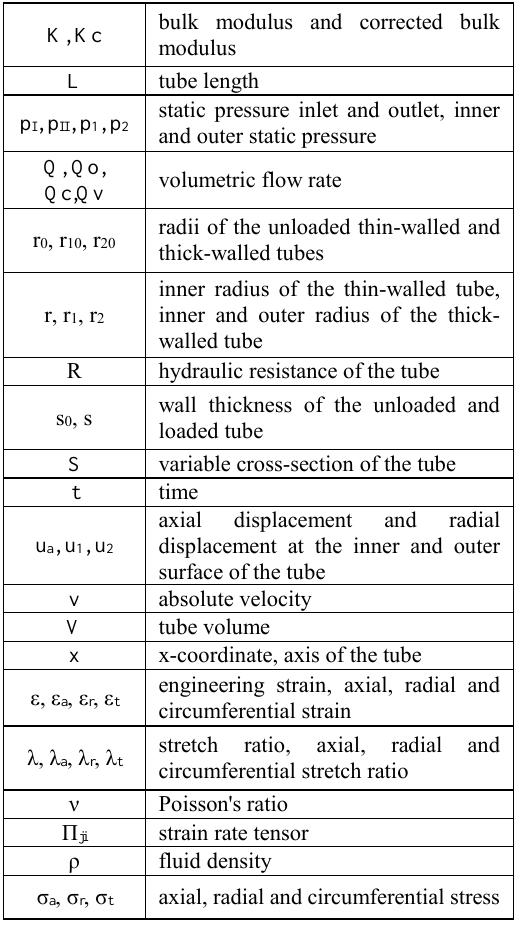
Figure 1. represents the simplest circuit to create a one- dimensional tube model. By using an electric analogy [10,11], the properties of the tube are concentrated to the capacity C , the hydraulic resistance R and the induction H . The position and number of C , R and H depend, of course, on the wavelengths.